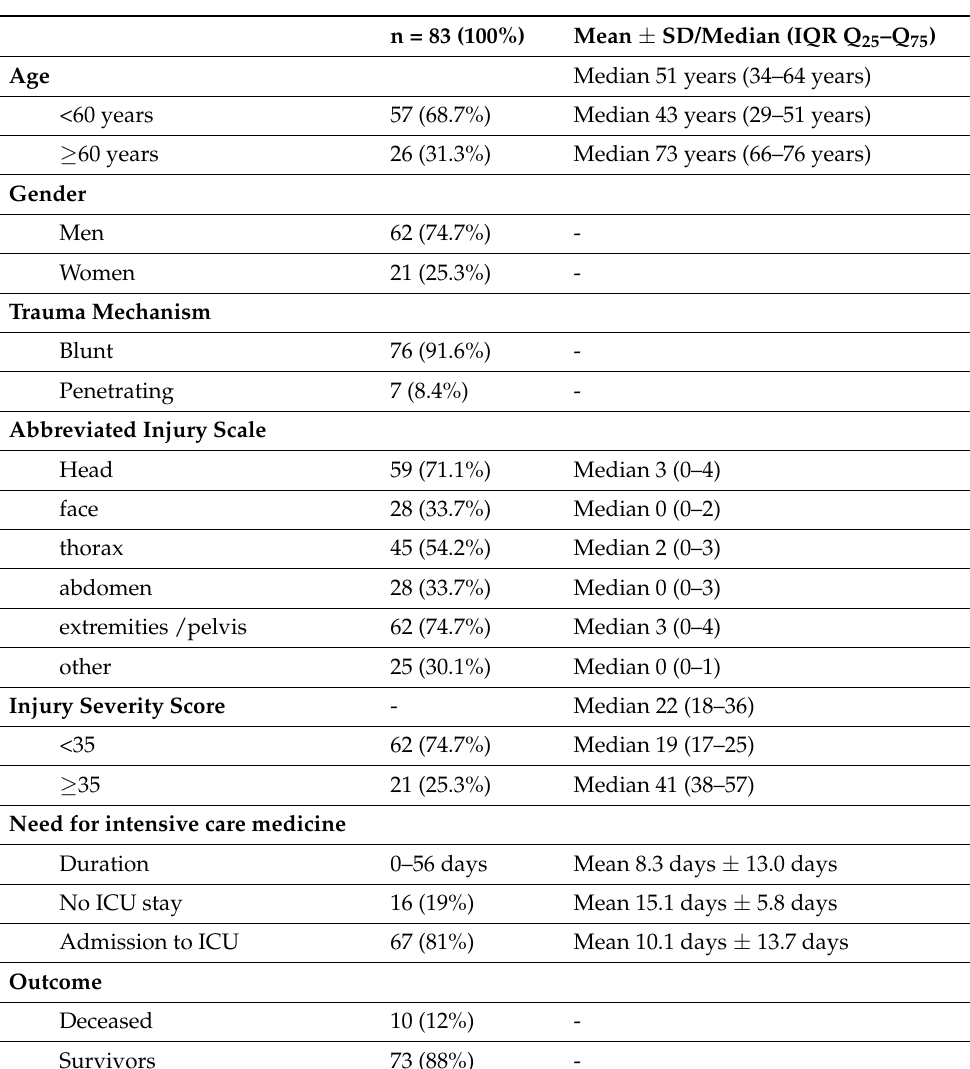
Table 1. Characteristics of the study